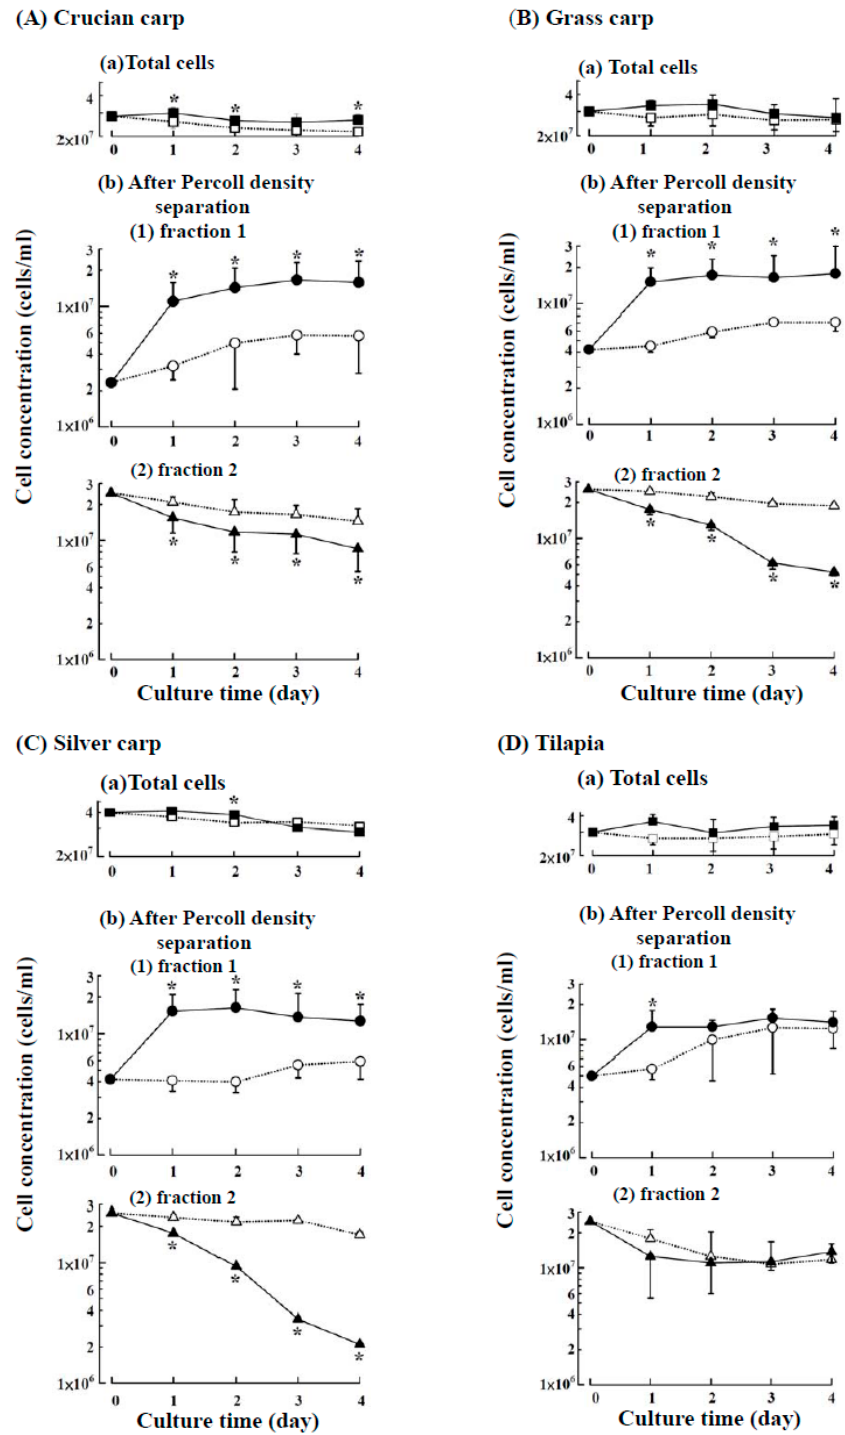
Figure 1. Suspension cultures of head kidney cells from the four fish species with or without ZnCl 2 supplementation. ( A ) Crucian carp; ( B ) grass carp; ( C ) silver carp; and ( D ) tilapia. All cells remained in suspension for four days. The growth curve of the total cells is shown in ( a ). The total cells were further separated by Percoll density centrifugation into fractions 1 and 2 ( p = 1.020 and 1.070 g/mL), and the growth curves are shown in b ( 1 ) and b ( 2 ), respectively. Filled symbols and continuous lines represent cultures supplemented with ZnCl 2 ; open symbols and broken lines represent cultures without ZnCl 2 . The data are expressed as the means ± SDs of four independent experiments. * Statistically significant differences with p < 0.05 between the groups supplemented with or without ZnCl 2 .